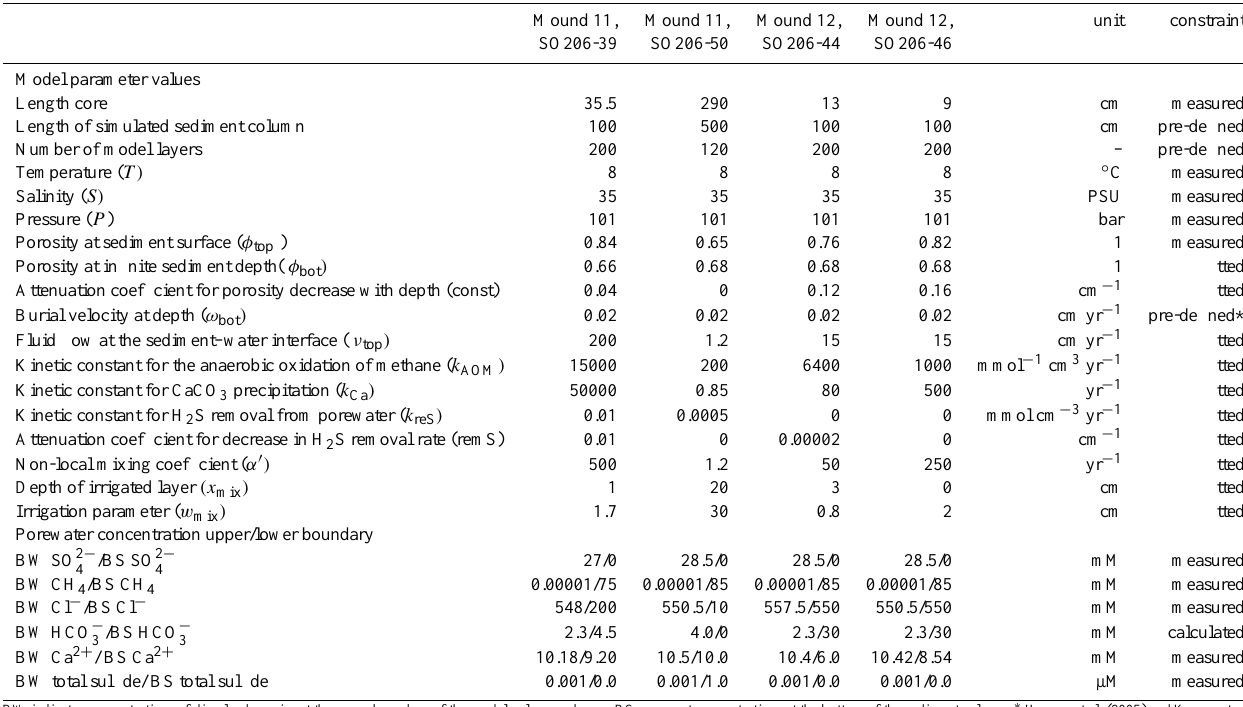
Table 3. Summary of model input parameters and boundary conditions used for numerical modelling of biogeochemical processes at Mound 11 and